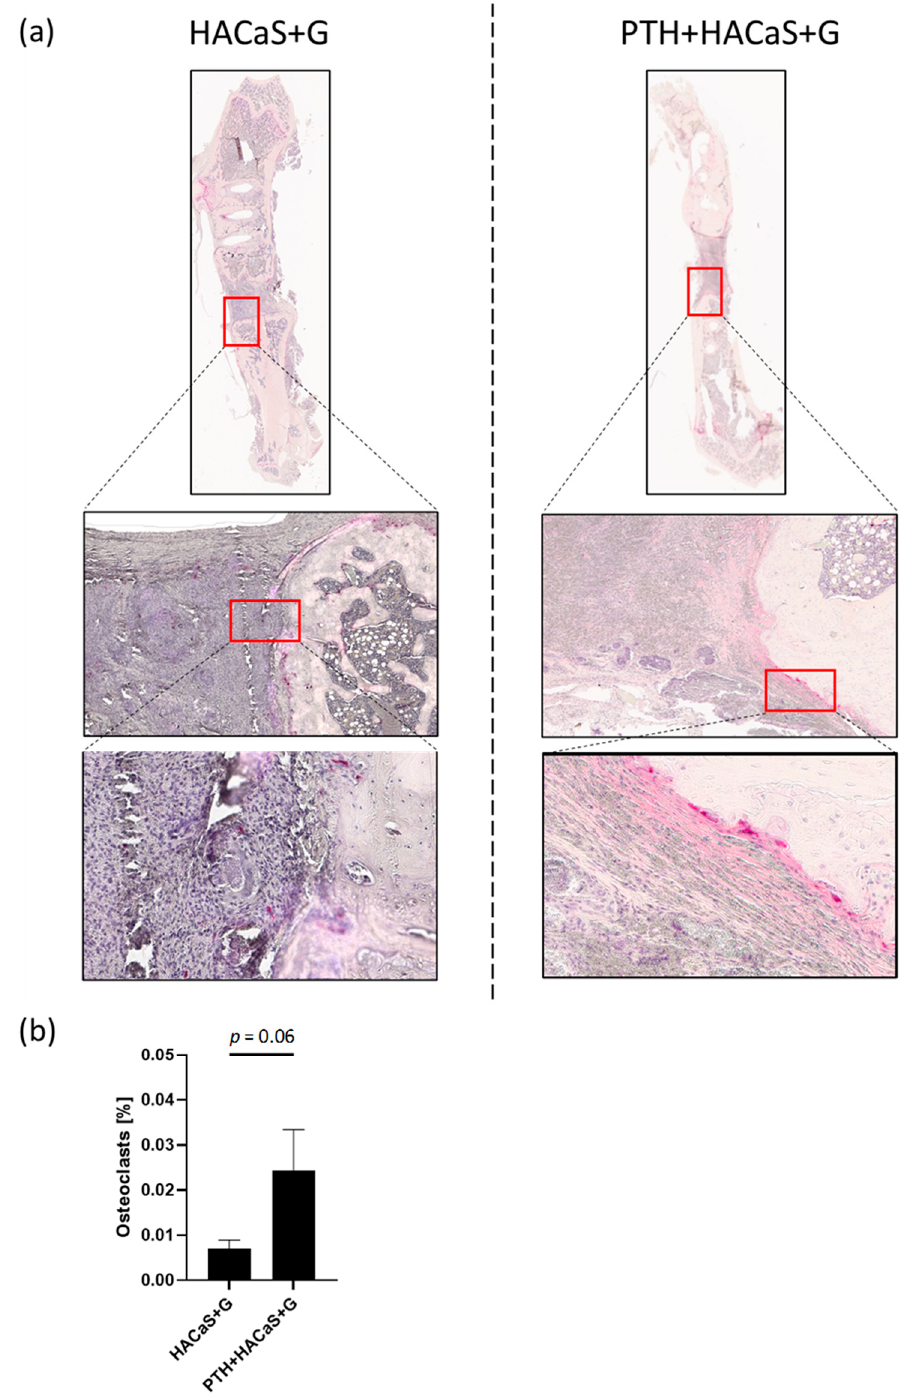
Figure 6. TRAP staining shows invasion of osteoclasts in HACaS+G: ( a ) TRAP staining (osteoclasts with red staining), and ( b ) quantification.